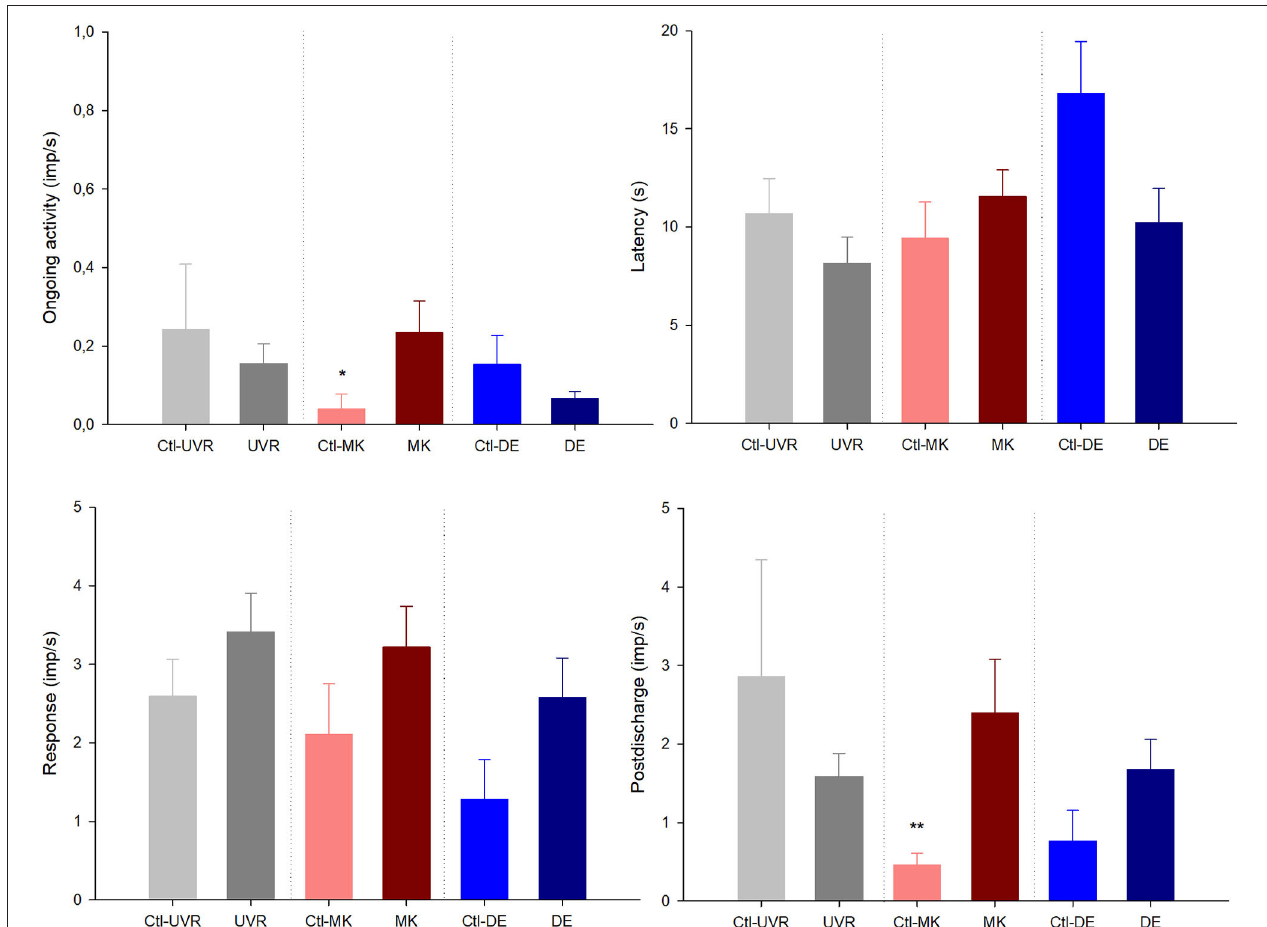
FIGURE 2 | The effects of unilateral UV irradiation, microkeratome lesion, and main lacrimal gland removal on the ongoing activity and the response to the chemical stimulation with carbon dioxide (CO 2 ) of the polymodal nociceptor units recorded in the ipsilateral and contralateral (denoted by “Ctl” label) eyes. The data are presented as mean ± SEM. * p < 0.05, ** p < 0.01, t -test or Mann-Whitney, as needed, the differences between the data from the ipsilateral and contralateral eyes.